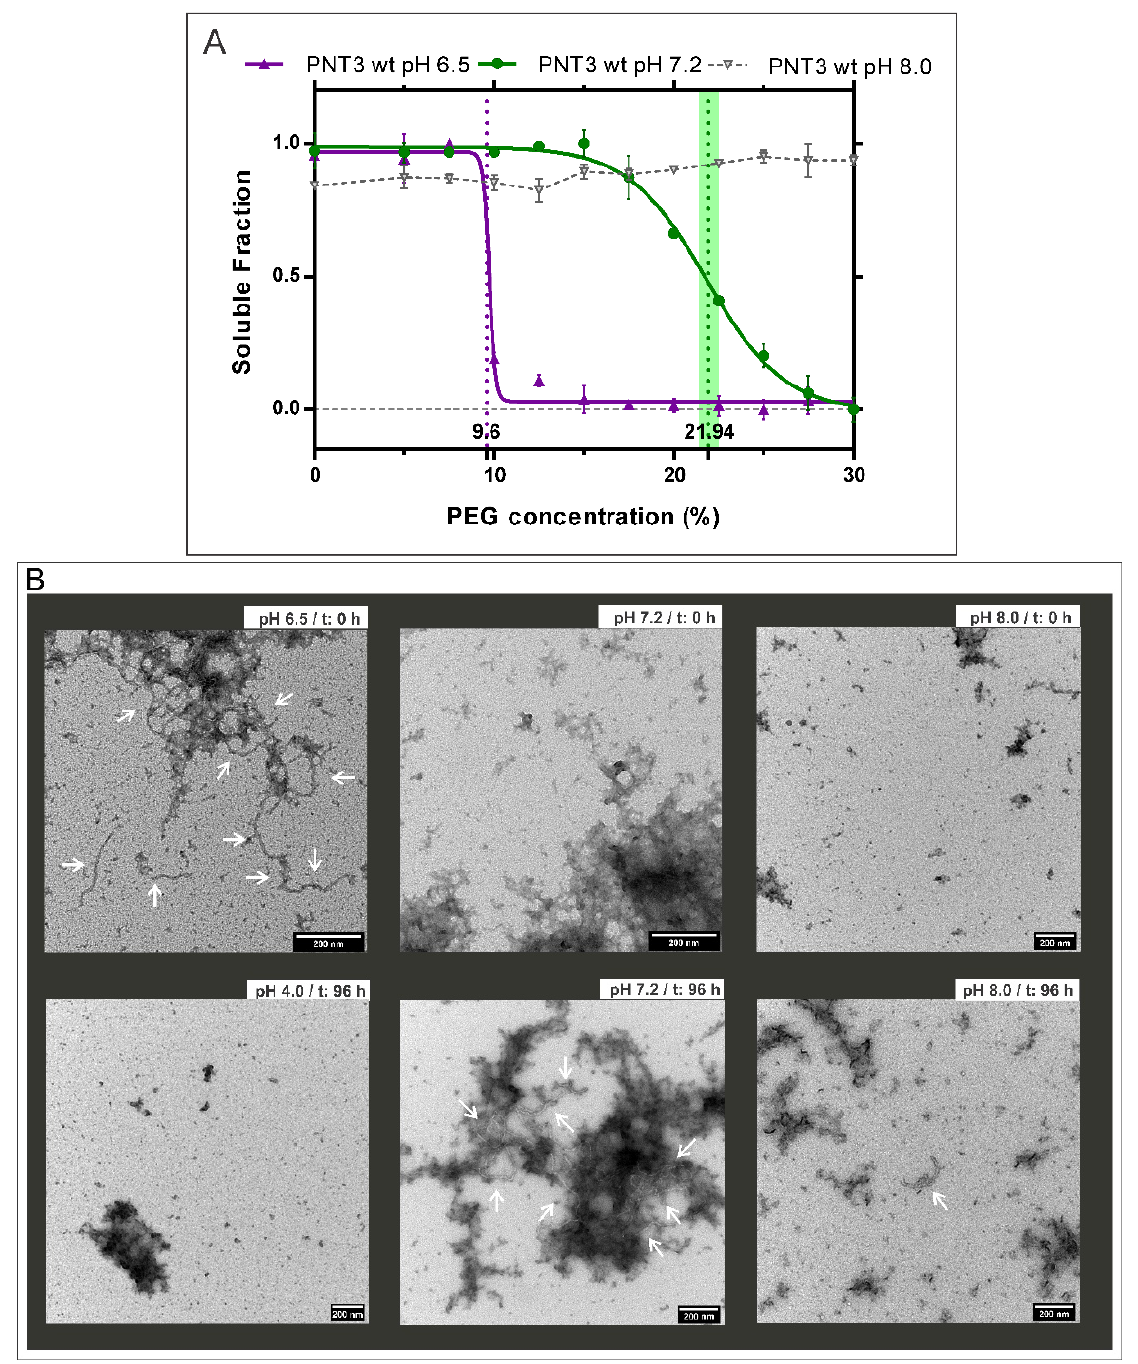
Figure 2. Fibrillation propensity of HeV PNT3 wild-type ( wt ) at different pHs. ( A ) PEG assay and relative solubility of HeV PNT3 wt at pH 7.2 (green), 6.5 (violet) and 8.0 (light gray). The vertical lines correspond to PEG 1/2 values (with their 95% confidence intervals) as obtained after a normalization and fitting step to a sigmoid function. Note that the curve obtained at pH 6.5 exhibits poor fitting thus preventing calculation of the confidence interval. Data points at pH 8.0 could obviously not be fitted. ( B ) Ns-TEM of HeV PNT3 wt fibrils at four different pH values: 6.5 (at time 0, t: 0 h), 7.2, 8.0 (at time 0 and after 96 h of incubation at 37 ◦ C, t: 96 h) and 4.0 (after 96 h of incubation at 37 ◦ C, t: 96 h). White arrows indicate